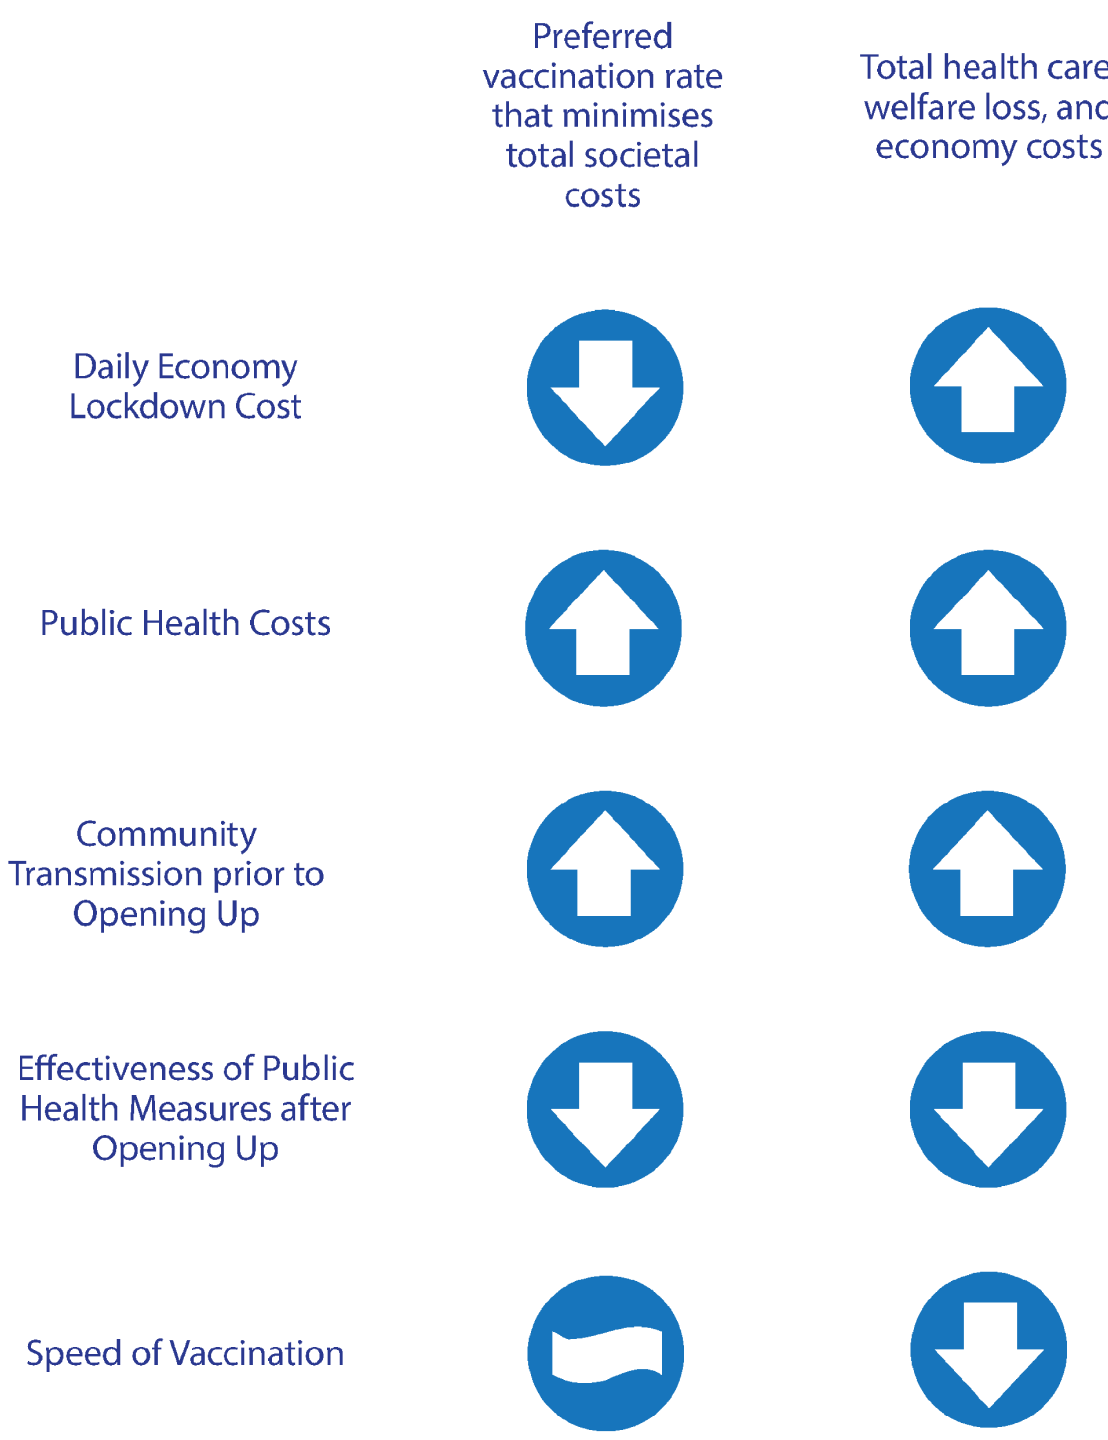
Fig 8. Summary of the sensitivity of the economically preferred vaccination target.